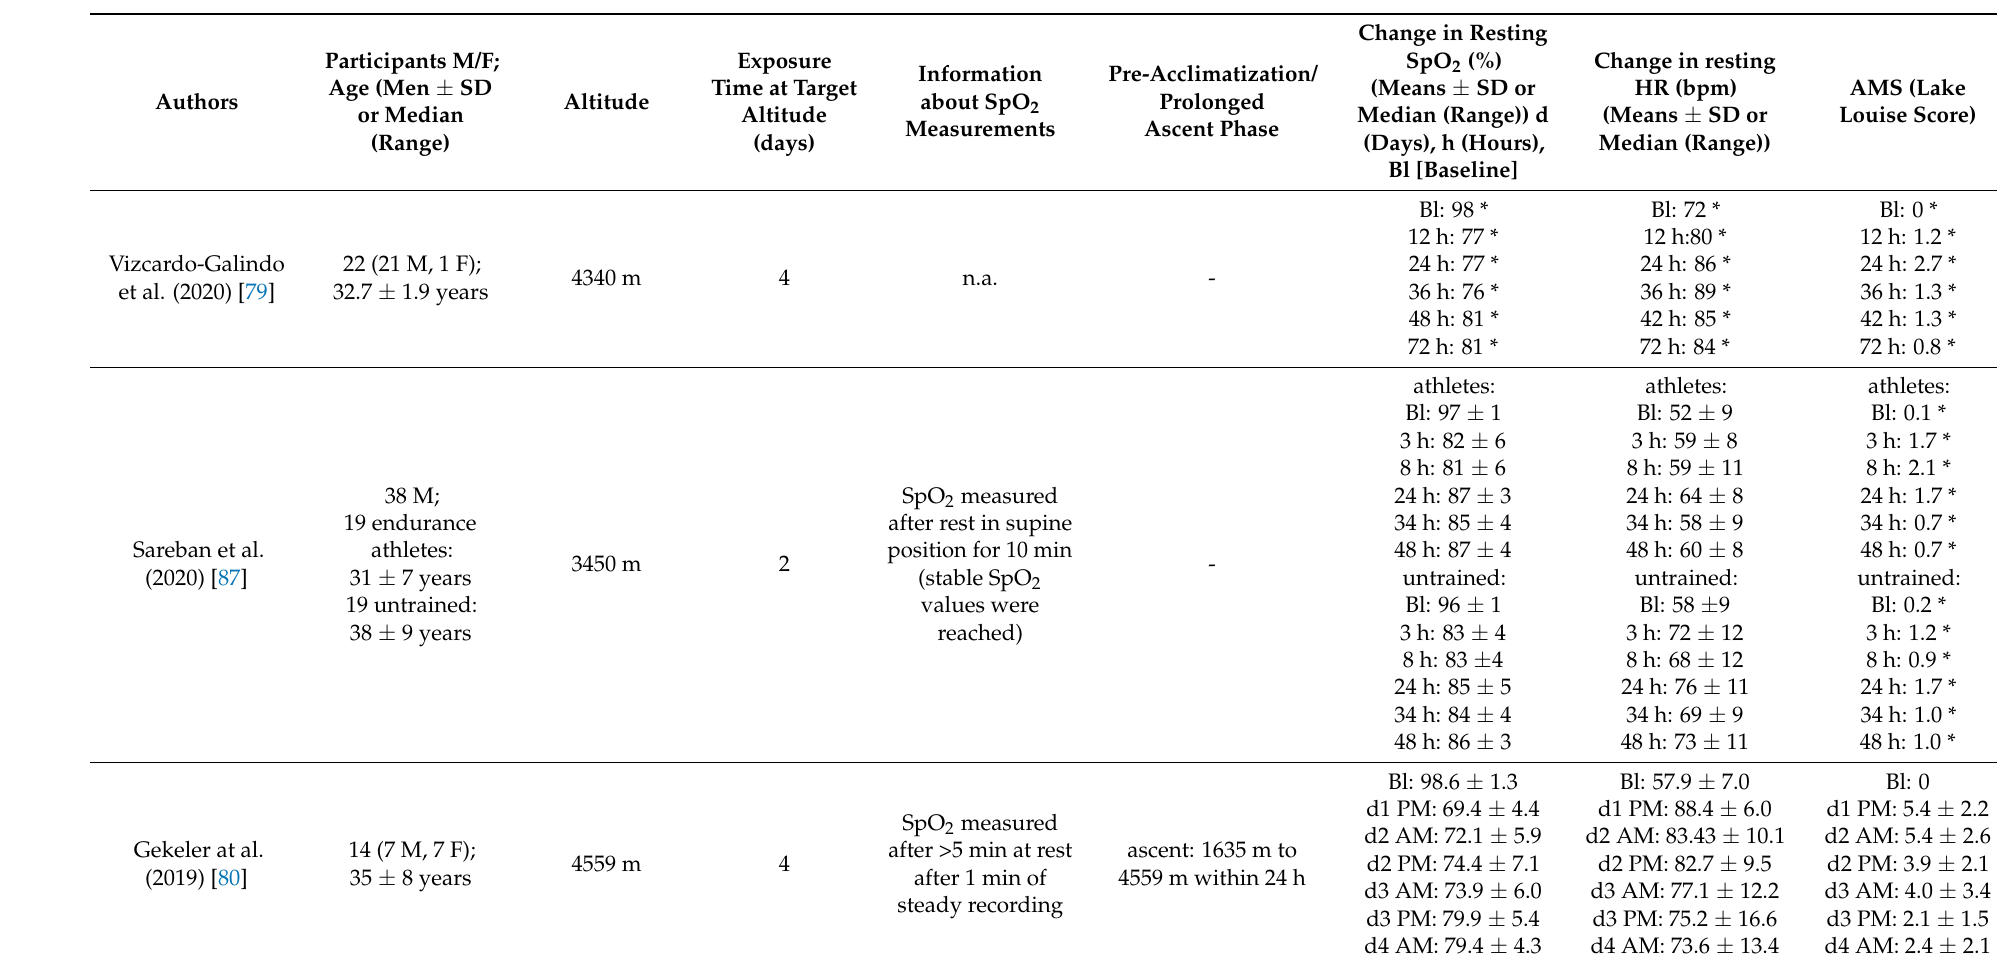
Table 4. Changes in AMS scores during stay at high